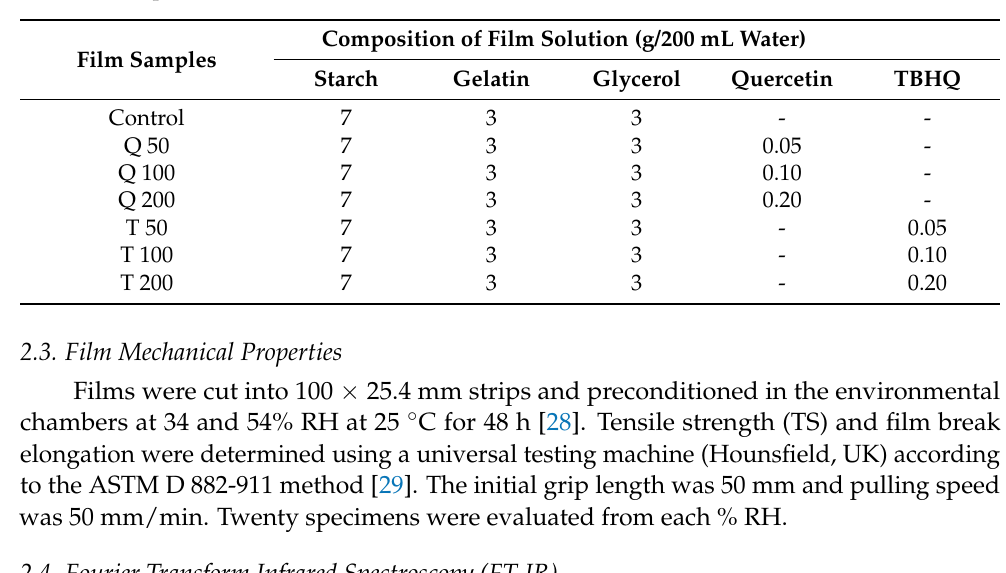
Table 1. Composition of film